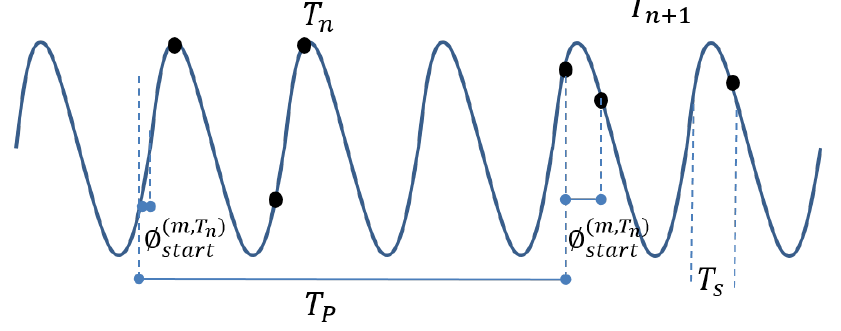
Figure 3. Illustration of availability